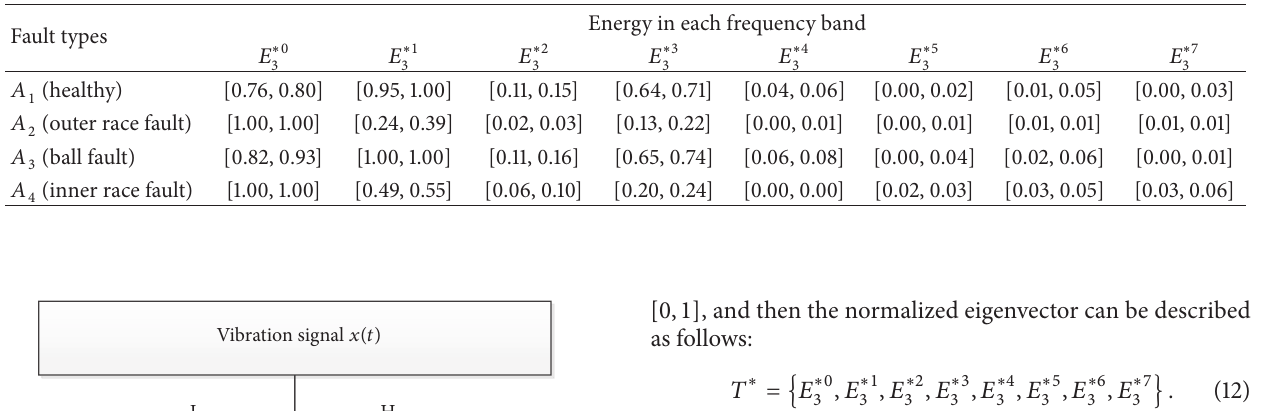
(b) Fast Fourier transform after morphological filter Figure 6: Signals of rolling bearing in ball fault. Table 3: Energy interval ranges at the eight subfrequency bands.